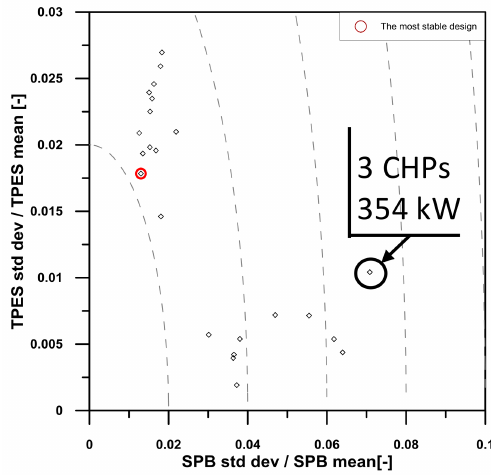
Figure 10. Pareto dominant solutions obtained through the first robust design analysis.